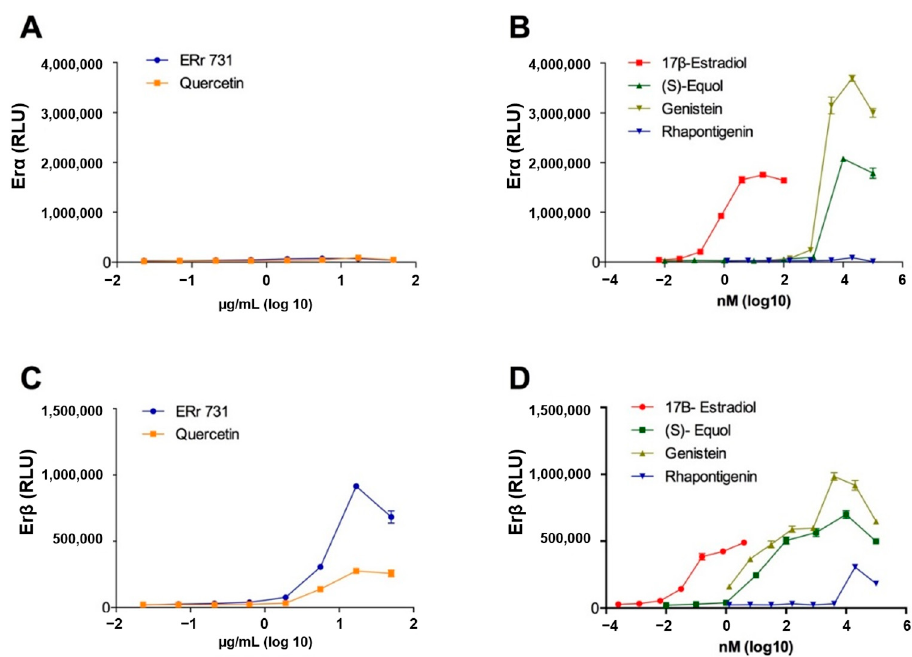
Figure 7. Induction of ER- α ( A , B ) activity versus ER- β activity ( C , D ) from ERr 731 extract as compared to quercetin, estradiol, equol, genistein and rhapontigenin. ER α or ER β reporter cells were treated in triplicate wells with various concentrations of test compounds for 24 h, and ER receptor activity was quantified as relative luminescence units (RLU). Agonist concentrations were transformed to log10 µ g/mL for botanical extracts or log10 nM for single compounds. Each data point represents mean ± SD.